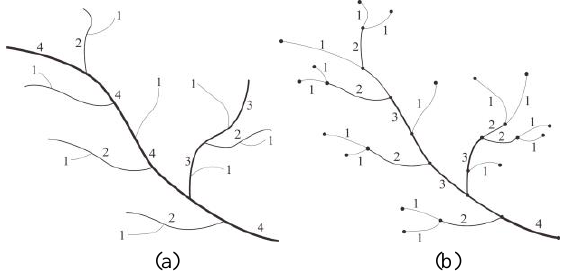
Figure 1. Two classic stream coding systems for dendritic river systems: (a) Horton coding and (b) Strahler coding